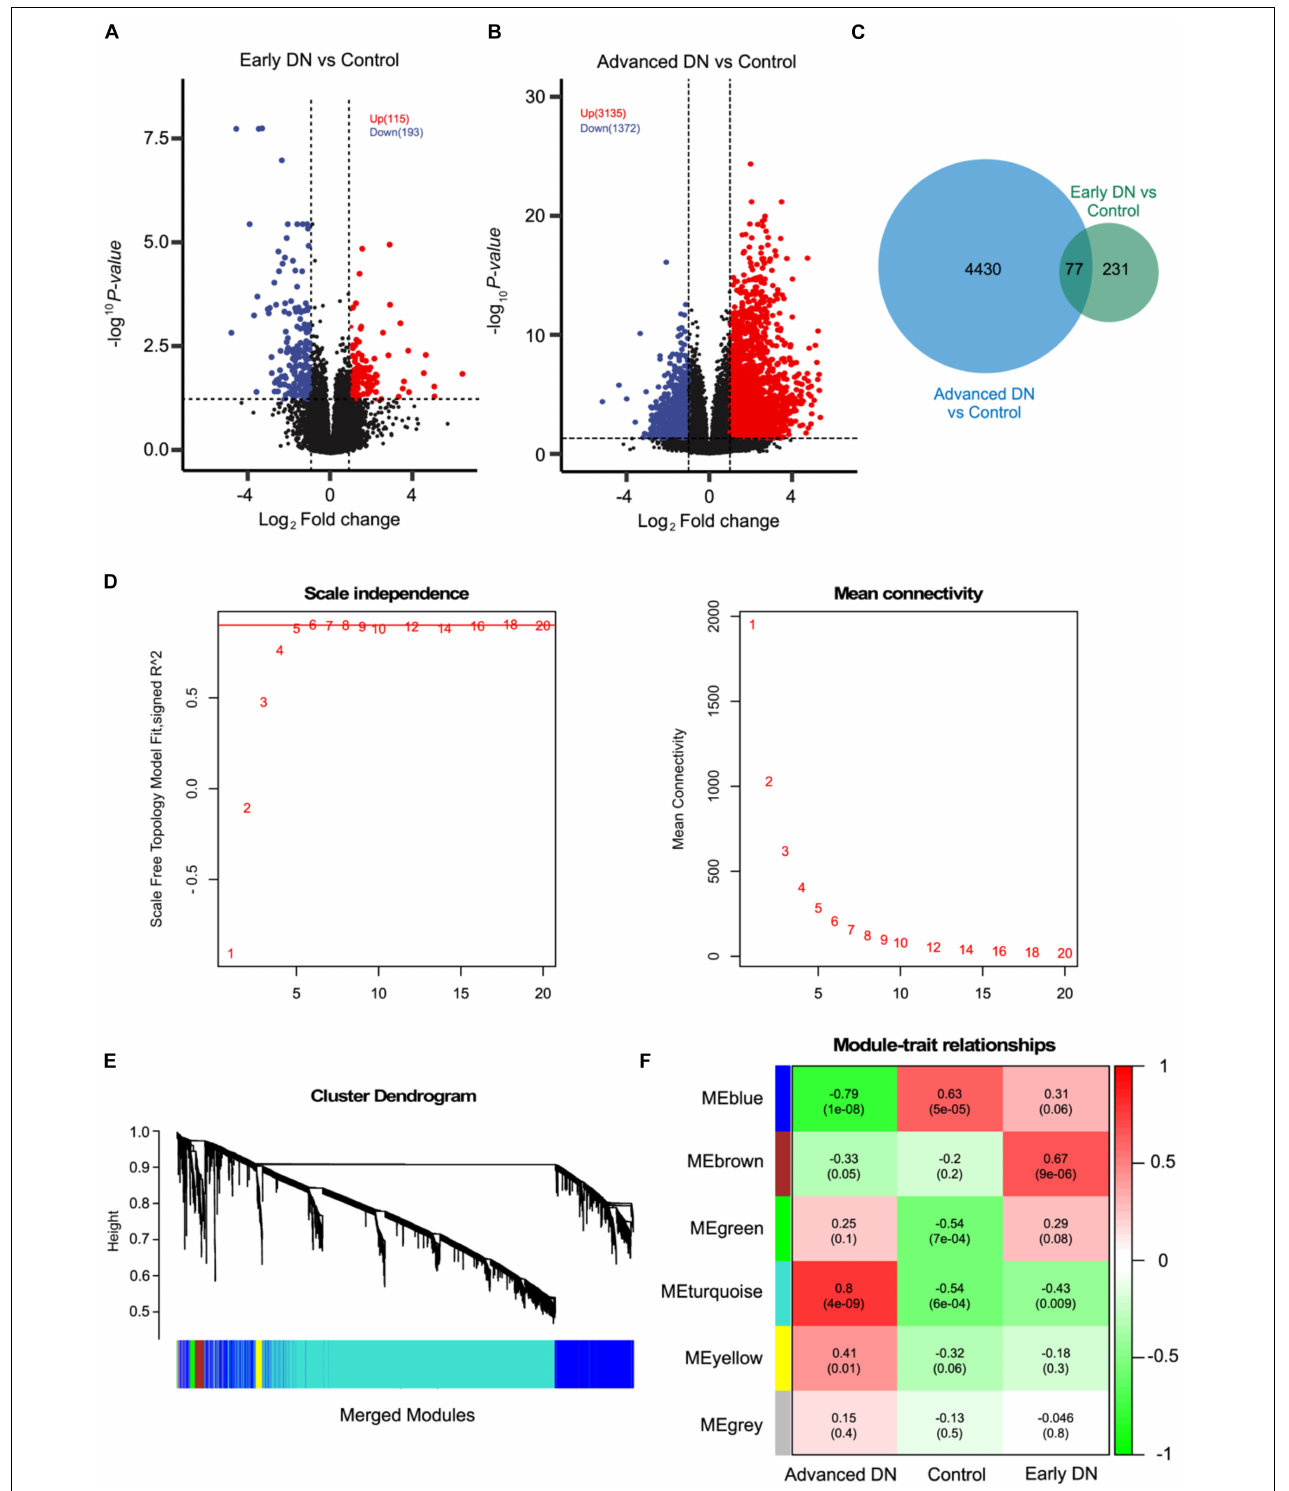
FIGURE 1 | WGCNA analysis based on RNASeq data revealed six co-expression modules. (A,B) Volcano plot showing the DEGs between early stage DN and control (A) and late-stage DN and control (B) . (C) Venn diagram showing the number of DEGs commonly and uniquely expressed between indicted groups. (D) The scale-free fit index (left) and mean connectivity (right) of the network topology at different soft-thresholding powers. (E) The cluster dendrogram of DEGs of patients with DN. Each line represents one gene, and each color below represents one co-expression gene module. (F) Correlation analysis between different co-expression gene modules and DN